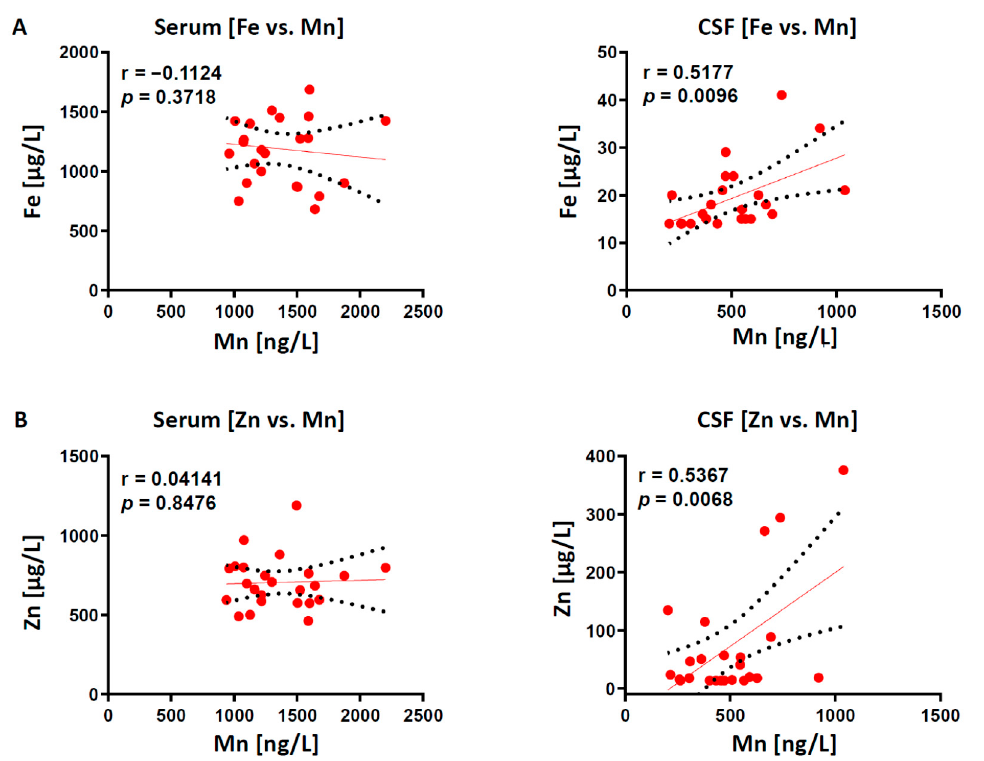
Figure 2. Pearson’s correlation analyses are shown for “Fe vs. Mn” and “Zn vs. Mn” interactions in 24 matched serum and CSF samples. ( A ) “Fe vs. Mn” is positively correlated only in CSF, but not in matched serum samples. ( B ) “Zn vs. Mn” is positively correlated only in CSF, but not in matched serum samples. “r” marks the linear Pearson correlation coefficient.